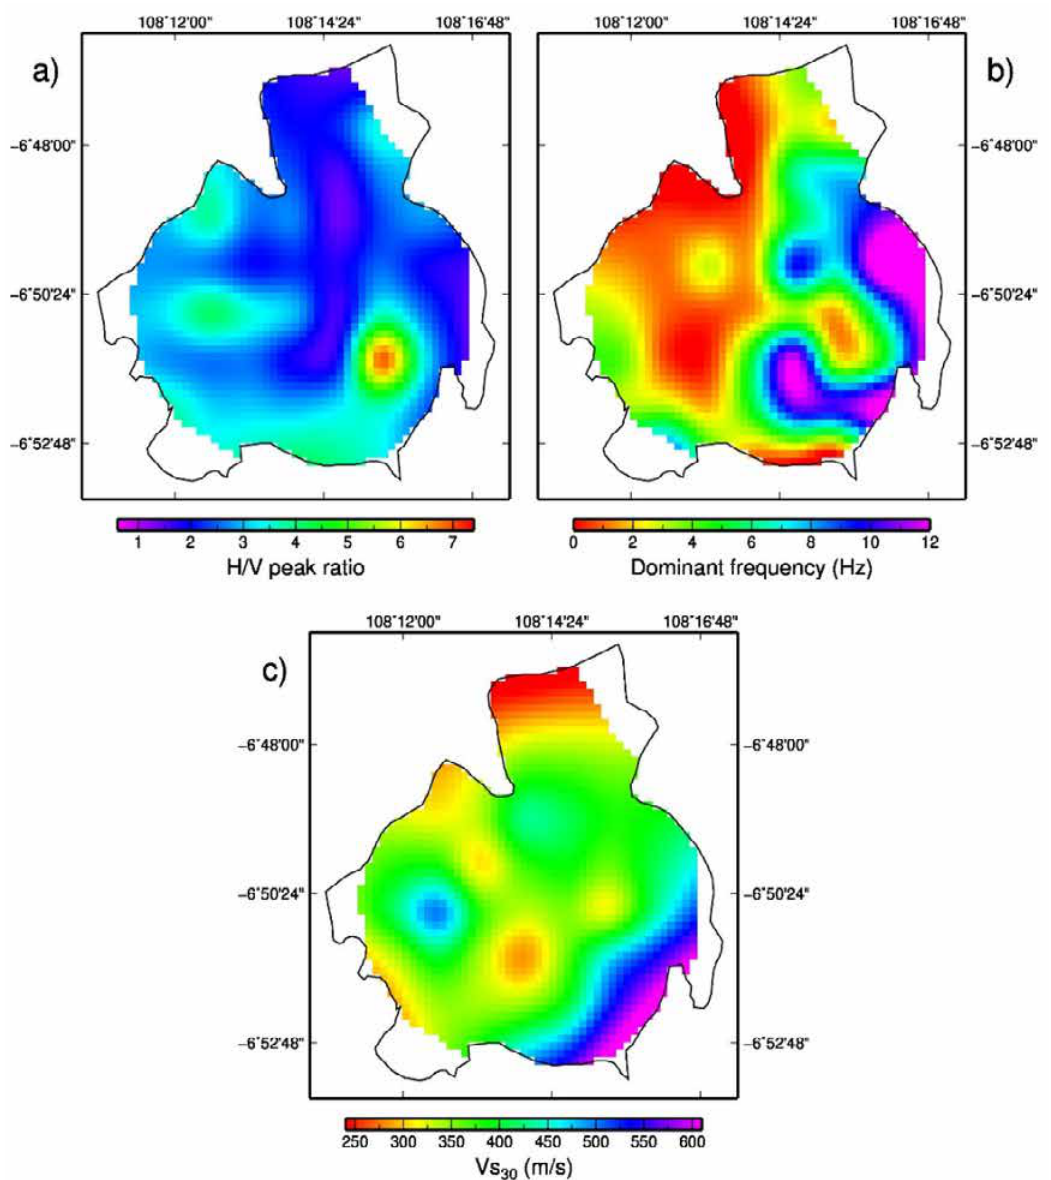
Fig. 4: Maps of interpolated seismic properties of (a) H/V peak ratio, (b) dominant frequency from ambient microtremor data, and (c) Vs 30 derived from the MASW data. The black outline shows the district boundaries of Majalengka